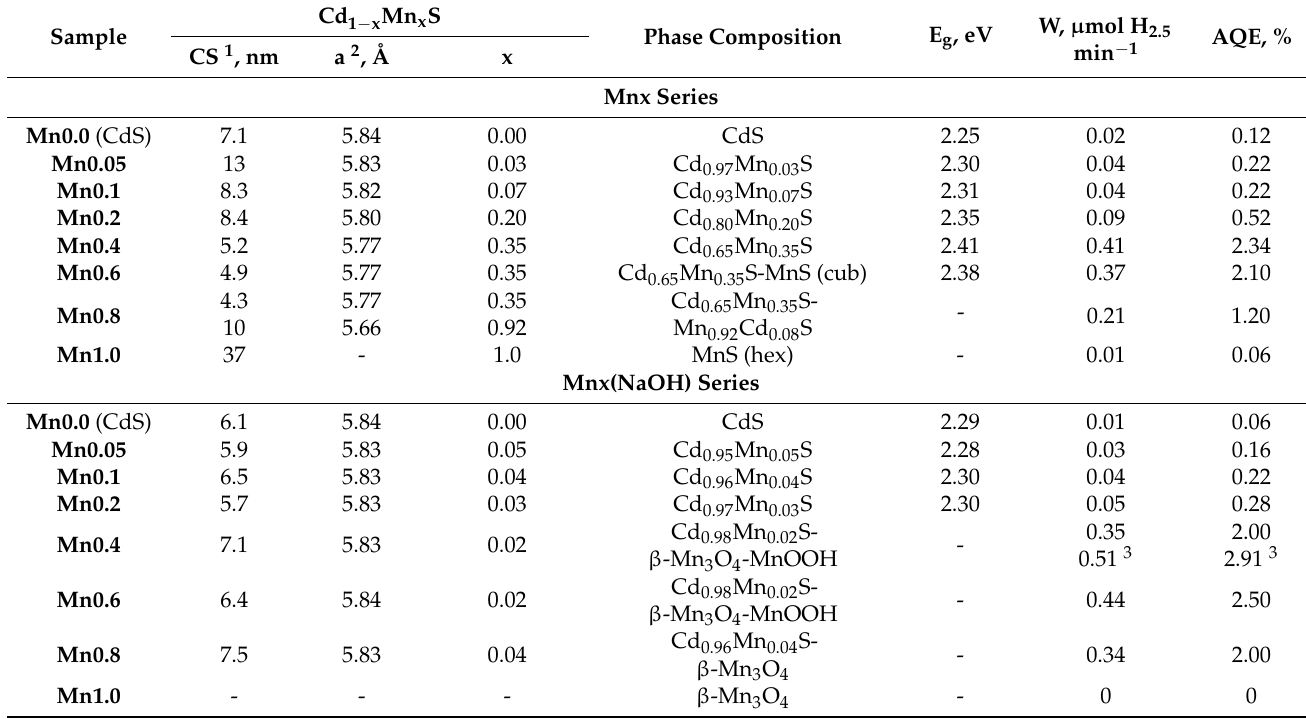
Table 1. The phase composition and structural properties, and activities of the synthesized photocatalysts. Conditions: C 0 (Na 2 S/Na 2 SO 3 ) = 0.1 M, C cat = 0.50 g L − 1 , λ = 450